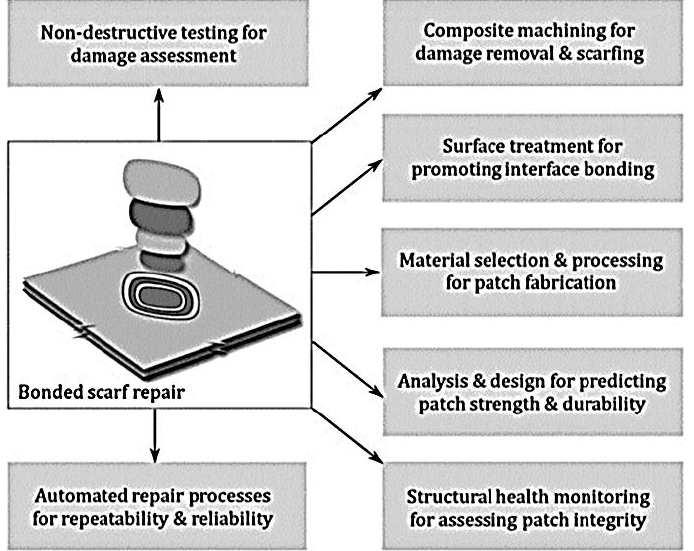
Figure 4. Research challenges for developing robust bonded scarf remedial technology. Reproduced with permission from ref. [37].